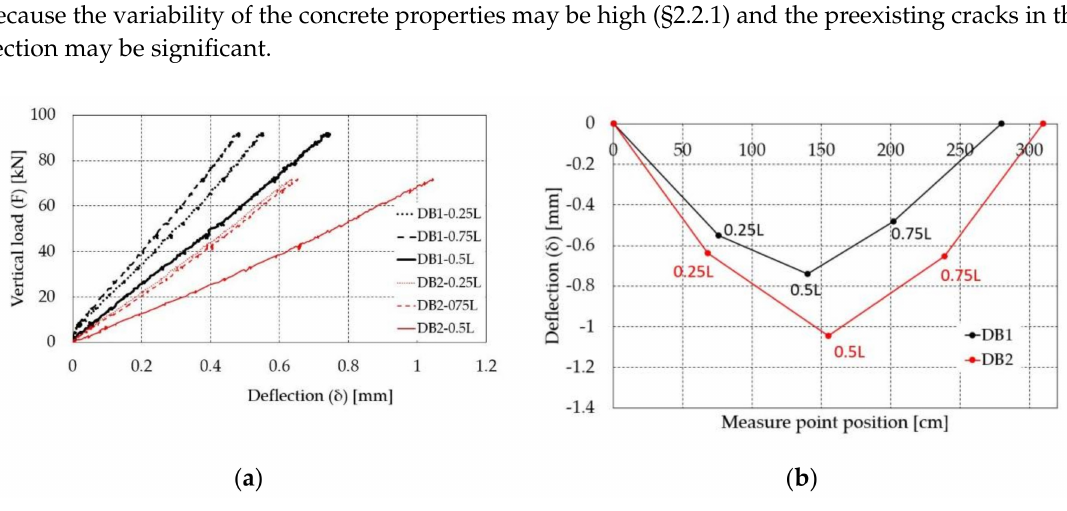
Figure 6. Extracted beam DB1 and DB2: ( a ) load-deflection curves and ( b ) maximum beam deflections during the elastic tests (L is the beam